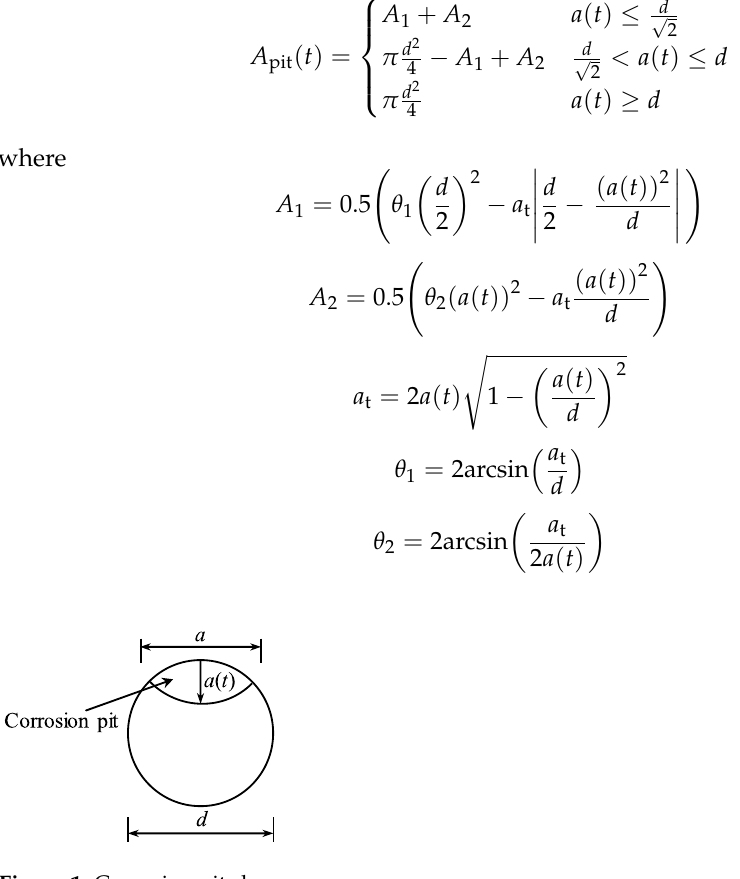
Figure 1. Corrosion pit shape.